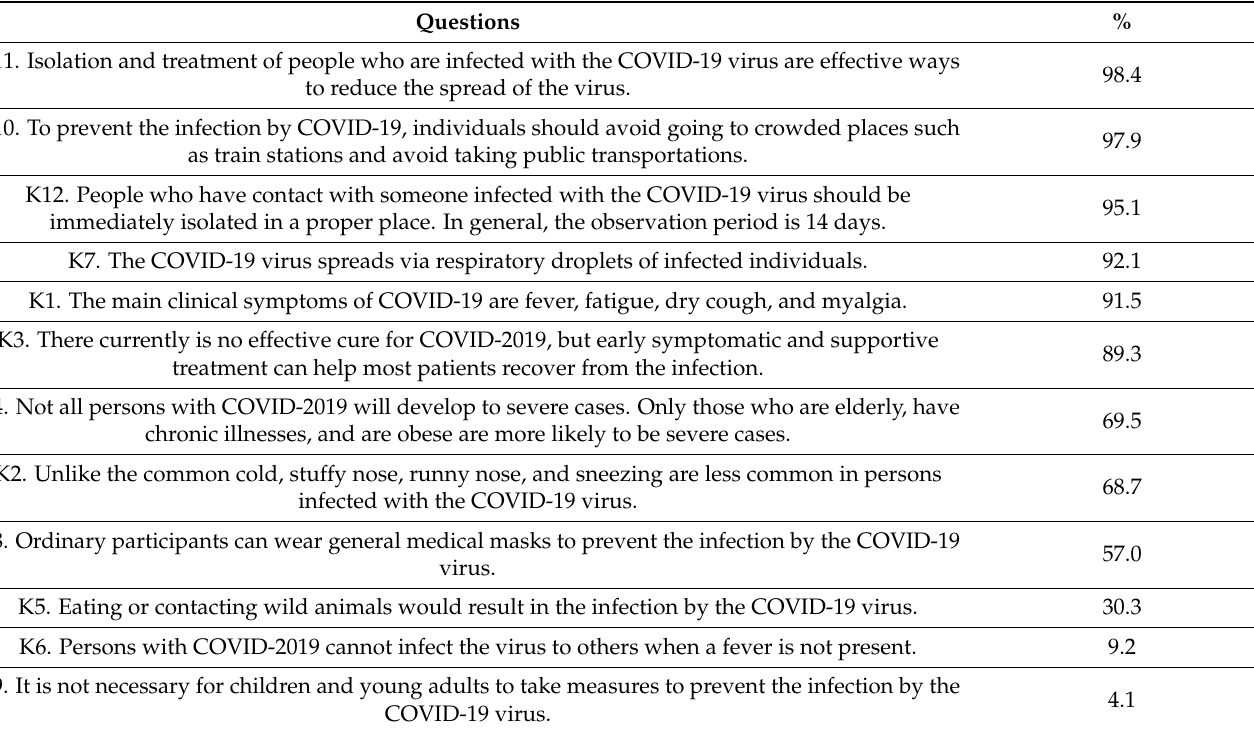
Table 3. The correct answer rates of the COVID-19 knowledge questionnaire. Questions